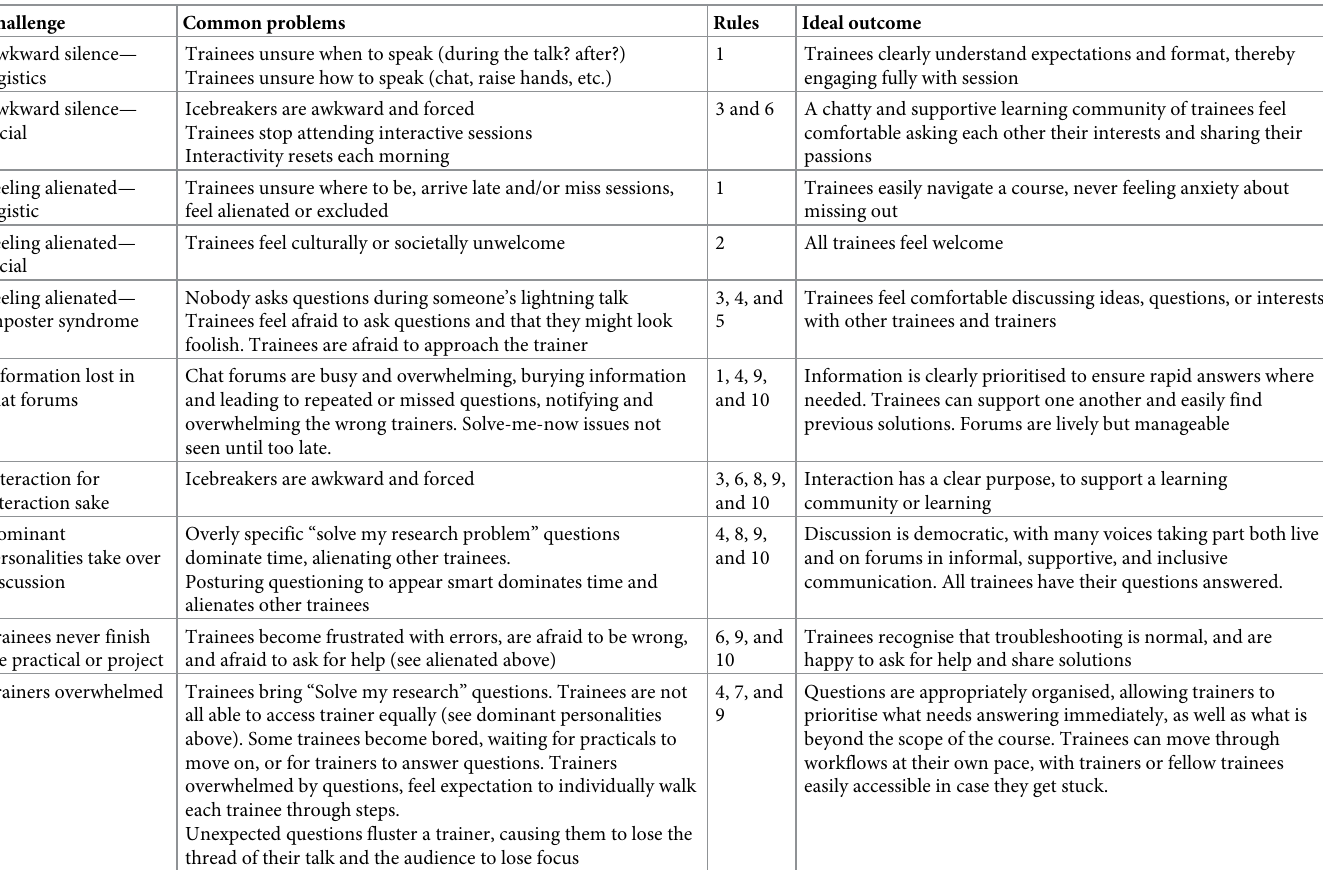
Table 2. Common problems in virtual course environments and how the 10 simple rules can fix them.